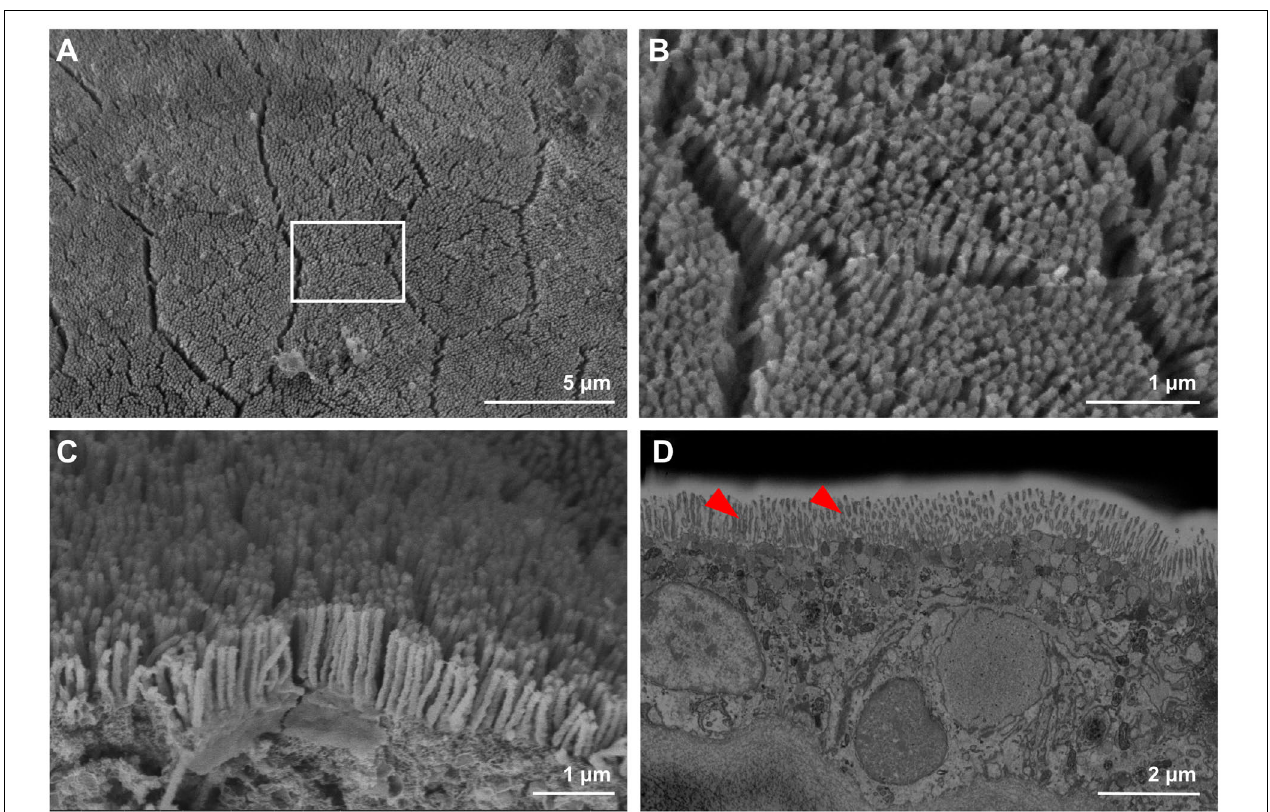
FIGURE 2 | Mantle surface structures of T. maxima , observed via and scanning electroscope microscopy (SEM). (A) Overview of mantle surface, with hexagonal features. (B,C) Magnified top view of mantle surface, revealing pillar-like microstructures. (D) Blockphase SEM of cross-sectioned mantle tissue showing topmost 10 µ m, including pillar-like microstructures, highlighted by red